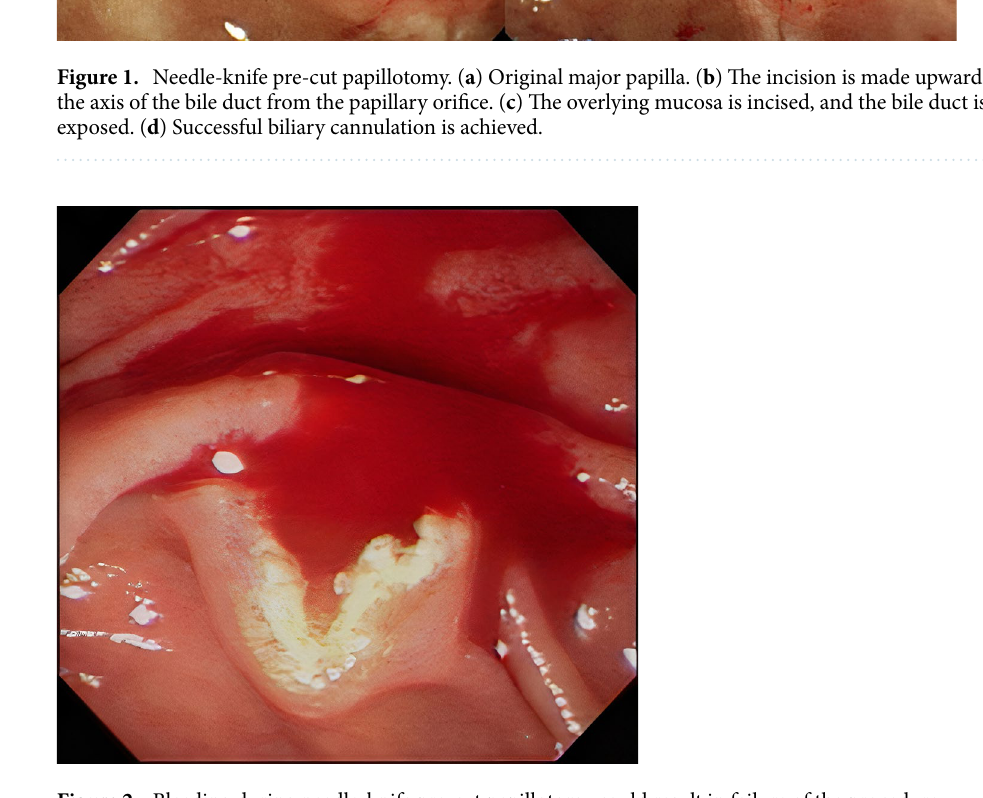
Figure 2. Bleeding during needle-knife pre-cut papillotomy could result in failure of the